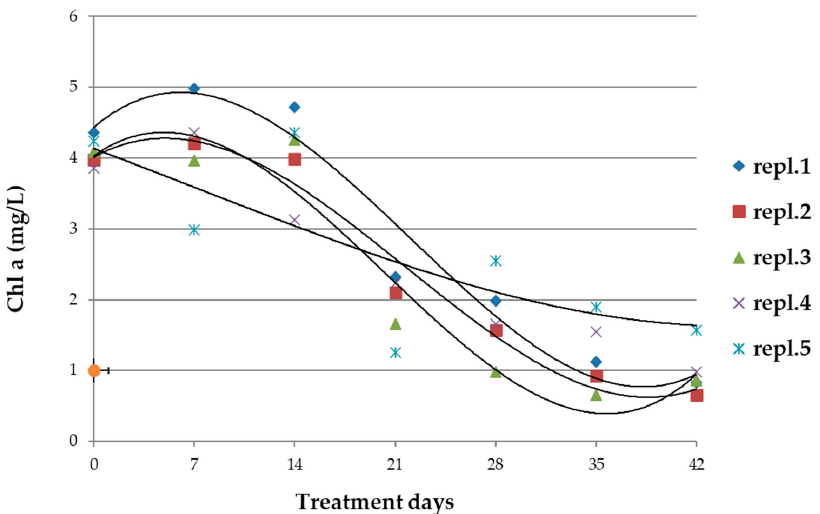
Figure 5. Trend of the concentration of chlorophyll a in samples (repl. 1–5) of A. maxima cultivations treated with 0.2 mM of glyphosate for 42 days and the mean of the concentration values ( ± ES) of reference samples. Regression lines (polynomials of 3rd degree) were calculated for each sample group. n = 5. The dashed line corresponds to the regression of the values in the reference cultivations. Statistical data and parameters are reported in Supplementary Table S1G.